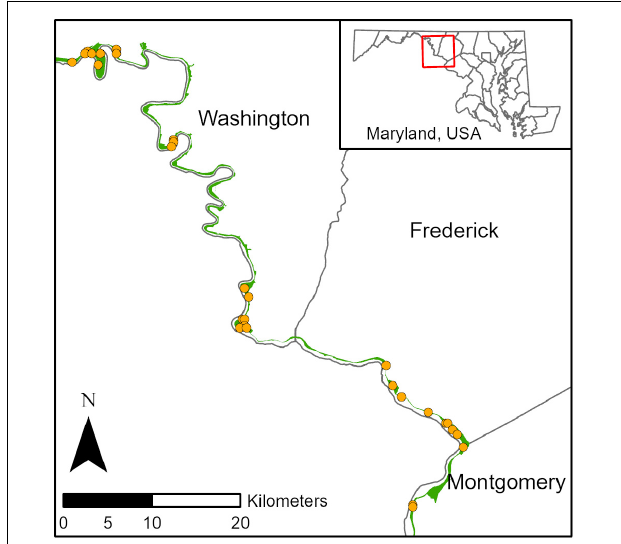
FIGURE 1 | Contextual map of study area showing location of plot centroids in Washington, Frederick, and Montgomery counties, Maryland, United States.